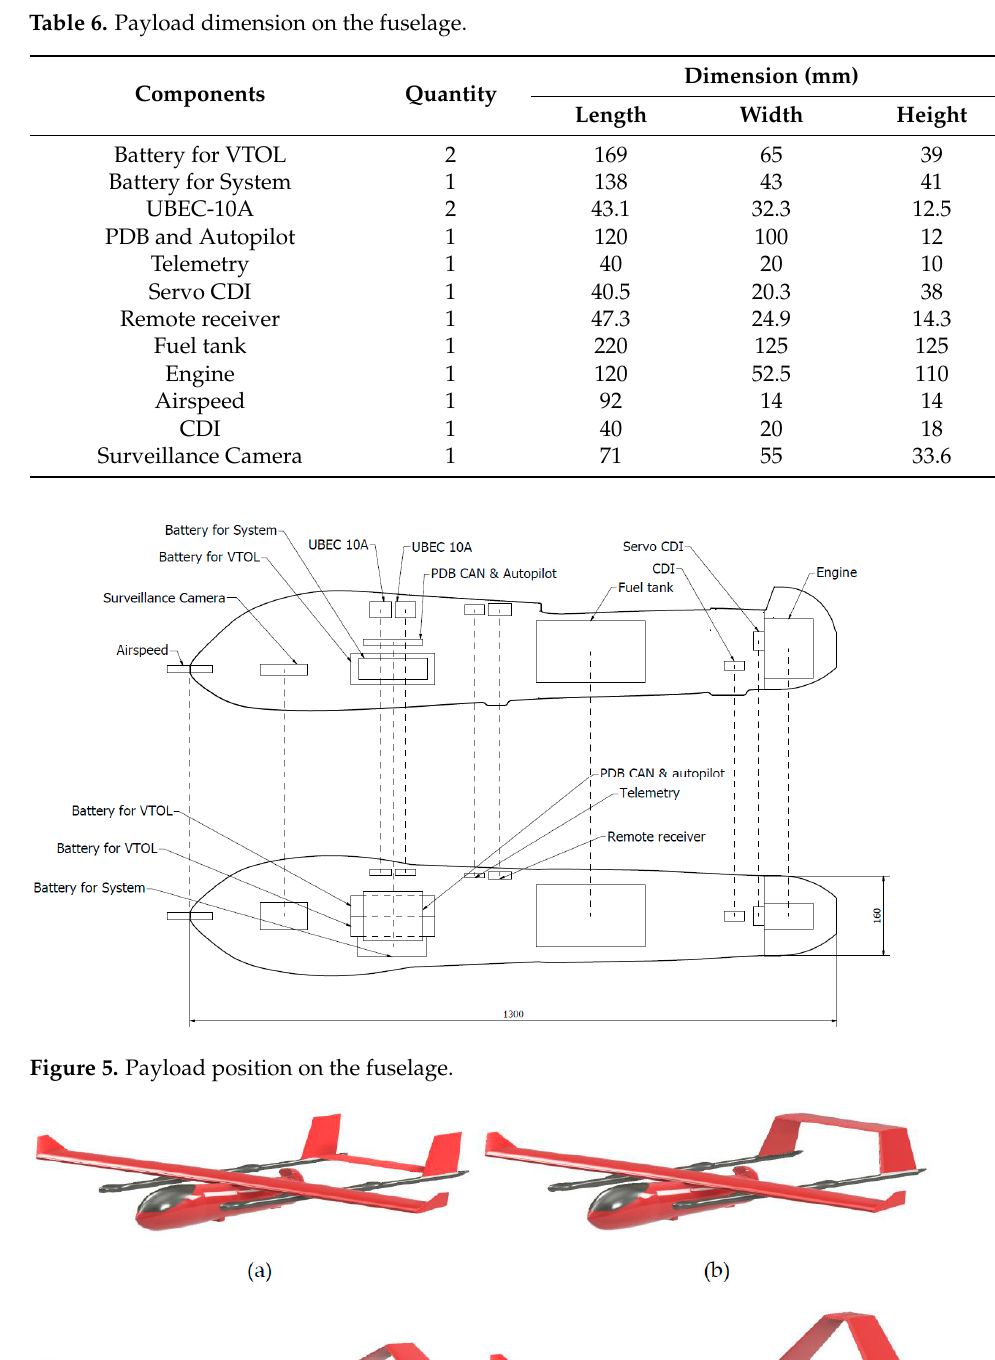
Figure 6. Three-dimensional geometry of the VTOL-Plane, with variations in empennage configu- rations: ( a ) U-shaped boom, ( b ) inverted U-shaped boom, ( c ) inverted V-tail boom, ( d ) semi-inverted V-tail boom. 2.5. CFD Simulation The next step was to run a CFD simulation on all the VTOL-Plane design variations. The parameters sought from the CFD simulation were the coefficient of lift ( C L ), the coef- ficient of drag ( C D ), the coefficient of moment pitch ( C P ), the coefficient of moment roll ( C r ), the coefficient of moment yaw ( C y ), the lift-to-drag ratio ( L/D ), the stall speed, and the maneuverability. The following steps are used when performing CFD simulations.